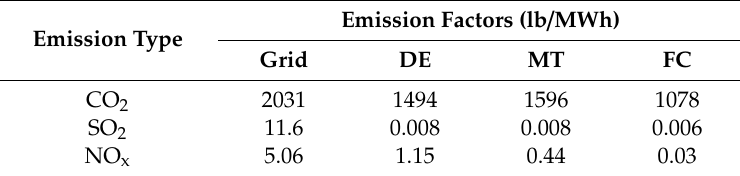
Table 3. Emission coe ffi cients related to grid and distributed energy resources (DERs) [34,35].